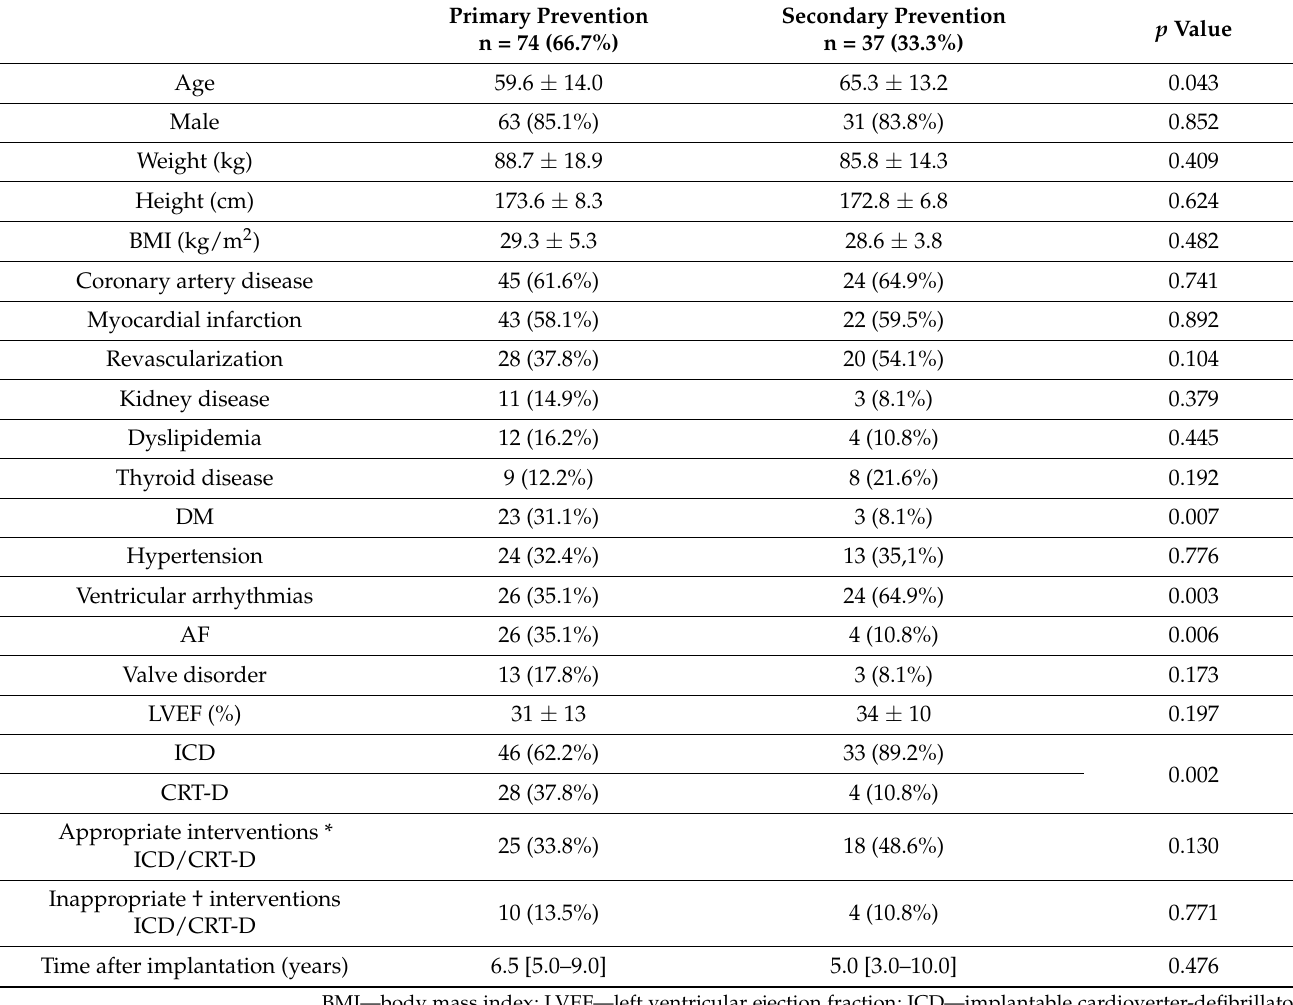
Table 1. Demographic and clinical characteristics of participants, according to type of prevention.